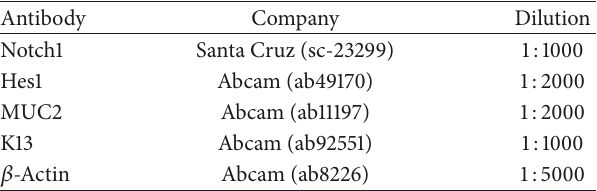
Table 2: Antibodies used for western blotting.